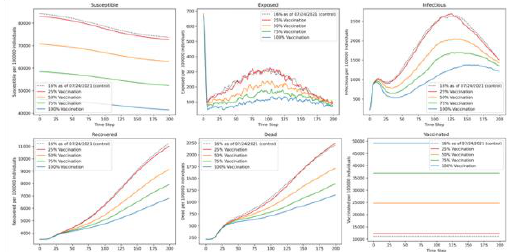
Figure 10. COVID-19 Temporal Dynamics for Quezon City, Philippines Under Various Vaccination